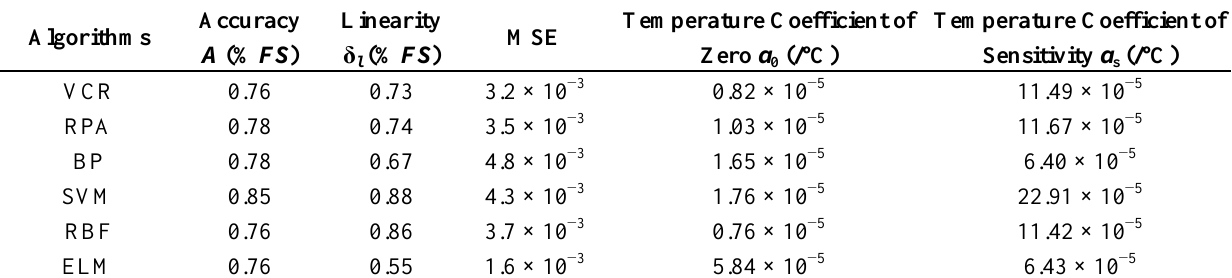
Table 2. Performances of sensor calibrated by algorithms using 3 × 3 calibration.